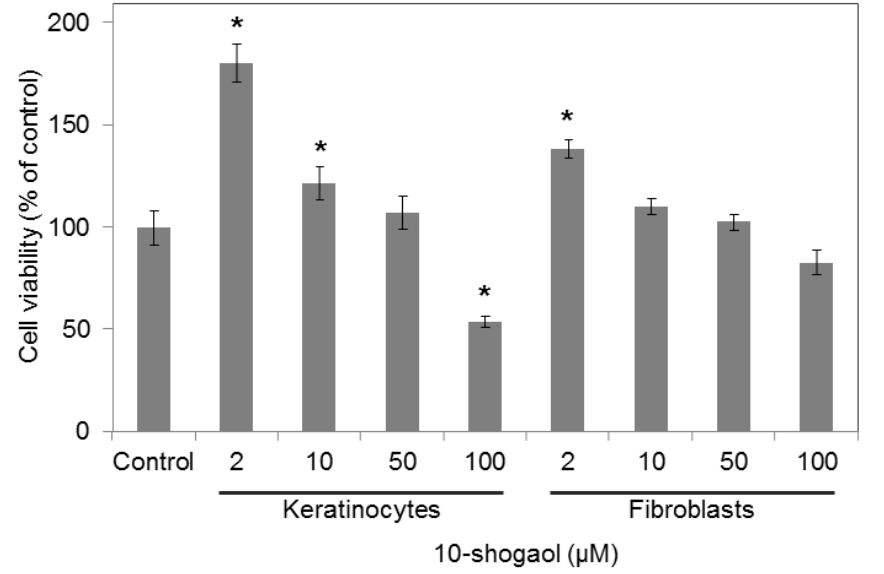
Figure 2. Human keratinocytes and fibroblasts cell growths were treated with 10-shogaol at various concentrations for 24 h culture. The graph illustrates the mean ± SD of three independent experiments. Bars: SD. * p < 0.05 against the vehicle control